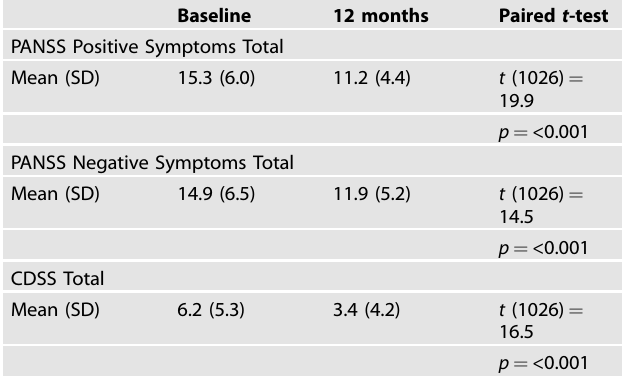
Table 2. Comparison of symptom scores across the baseline and 12- month